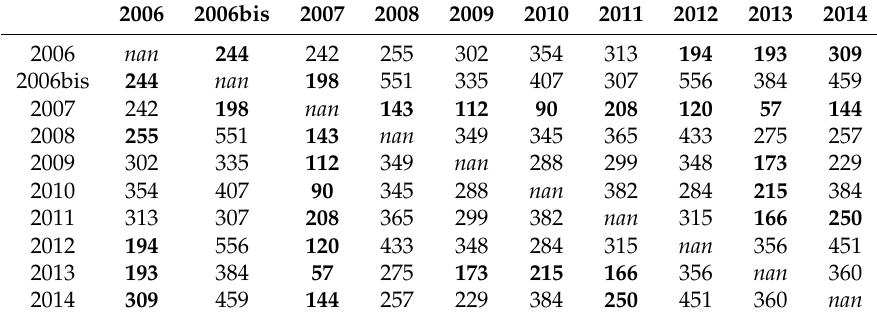
Table A1. Wilcoxon signed-rank test significance table for SLOO-CV computed from the overall accuracy of the 50 predictions for each single-year SITS. In bold , where p <